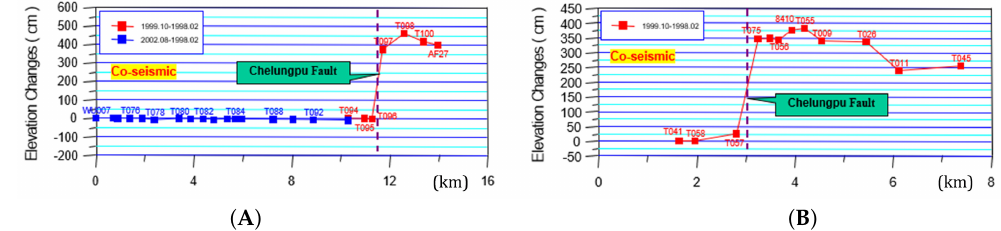
Figure 3. Levelling deformation profiles of 2 lines: ( A ) WU007-AF27, ( B ) T001-T045. See Figure 1D for profile